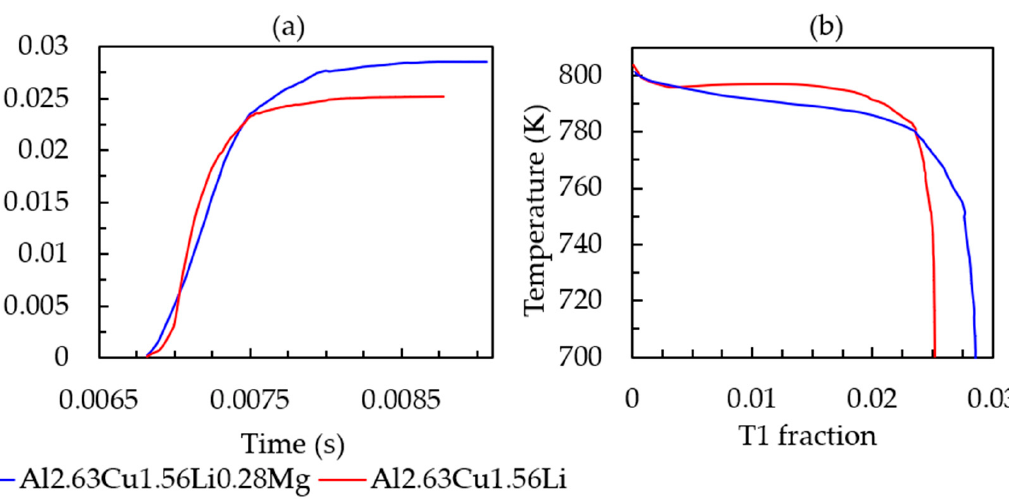
Figure 11. ( a ) T 1 fraction versus simulation time. ( b ) T 1 fraction versus temperature for Al-2.63Cu-1.56Li and Al-2.63Cu-1.56Li-0.28Mg droplet solidification.